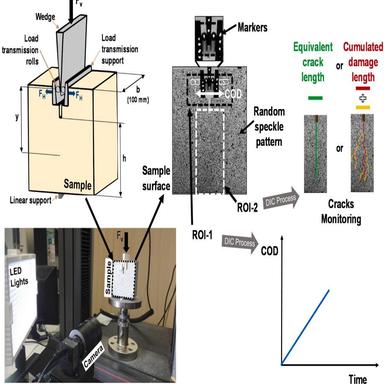
WST setup including sample geometry with loading conditions, markers on metallic loading parts, random speckle pattern on lateral sample surface, images acquisition and final DIC treatment on two Regions Of Interest: ROI-1 for measuring Crack Opening Displacement (COD) by classical DIC and ROI-2 for monitoring crack propagation within FPZ by 2P-DIC.